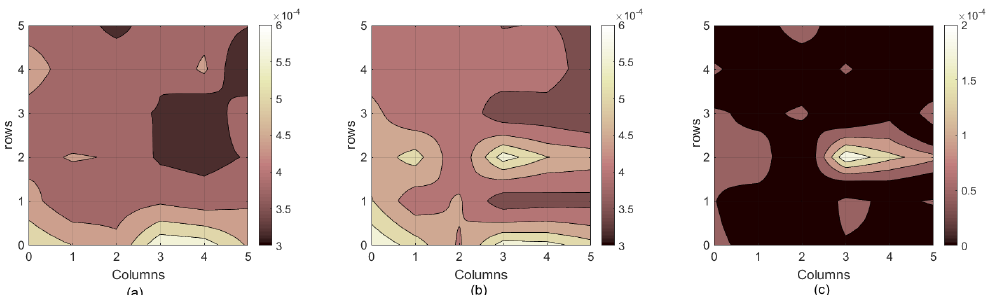
Figure 15. 2D mapping of electrical conductivity due to insertion of water in soil: ( a ) σ a before, ( b ) σ a after, and ( c ) difference between σ a after and σ a